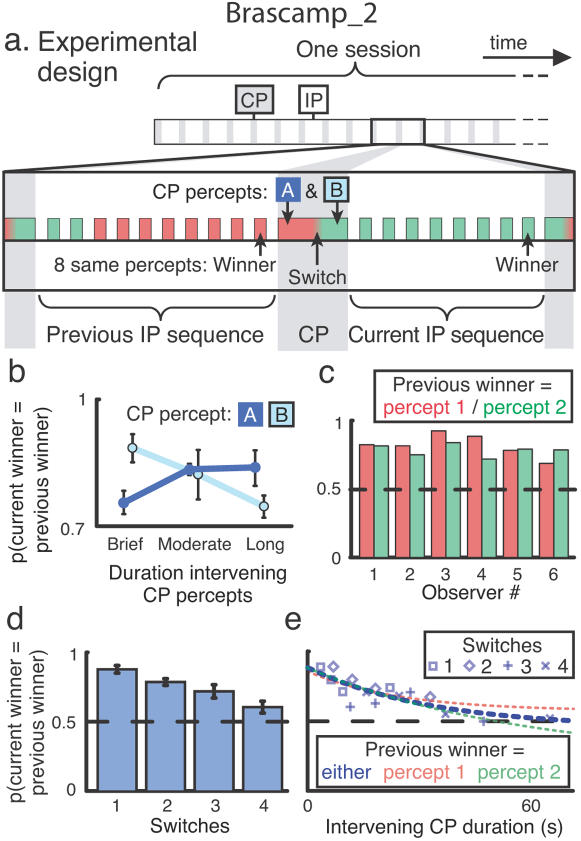
The effect of spontaneous perceptual switches on perceptual stabilization.a. Experimental design, Sequences of intermittent presentation (IP) were interleaved with periods of continuous presentation (CP). An intermittent presentation sequence ended when the same percept was reported on eight consecutive presentations. This percept was termed the sequence winner. In experiment one a continuous presentation period was terminated after a randomly varied delay (B) following the first perceptual switch. The duration (A) between the start of continuous presentation and this switch varied naturally. b. The probability that the current intermittent presentation sequence is won by the same percept as the previous intermittent presentation sequence rises with intervening duration A but falls with intervening duration B (both p<0.01; Spearman on individual subjects' data; n = 6; ρ = 0.68 for A and −0.56 for B). It remains above chance level throughout. Duration A varied continuously; the three data points were obtained by dividing the durations into three quantiles (average durations: 1.7, 4.1 and 11.6 s). c. The same probability plotted separately for cases where percept 1 (red) and percept 2 (green) won the previous intermittent presentation sequence. For each subject (x-axis) both bars reach above chance level, so the high correlation between the current winner and the previous winner does not reflect a systematic bias toward one percept. d. When allowing multiple perceptual switches (x-axis) during continuous viewing, the probability that the current winner equals the previous winner decreases as the number of intervening switches increases (p<0.01; Spearman on individual subjects' data; n = 7, ρ = −0.69). e. For one representative subject (others shown in Supporting Figure S2) the probability decreases gradually with increasing duration of the intervening continuous presentation period (x-axis), reaching chance after about a minute. This outcome is similar, whether one includes all data (blue curve and data points), or just cases where percept 1 (red curve) or percept 2 (green curve) won the previous intermittent presentation sequence. Error bars indicate standard errors.